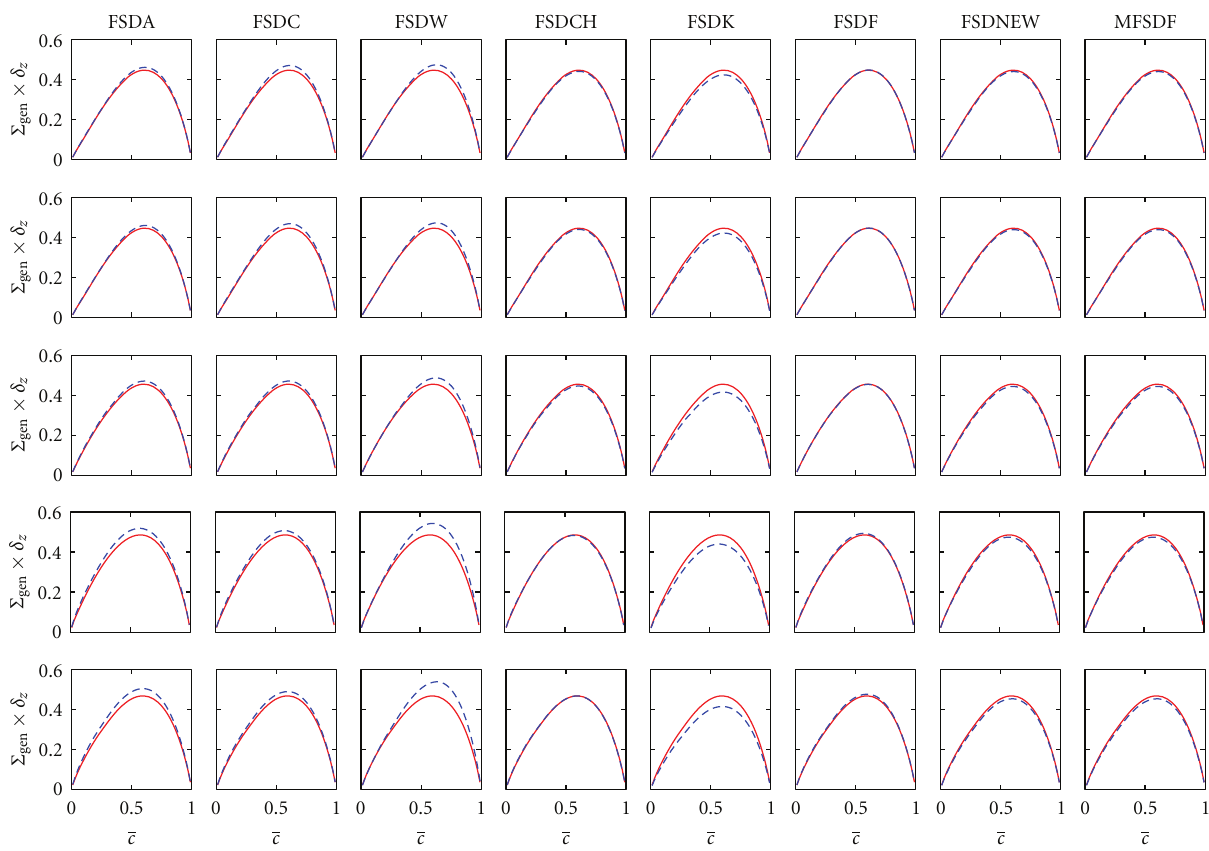
Figure 4: Variation of the mean values of Σ gen × δ z conditional on c across the flame brush for Δ = 8 Δ m = 0 . 8 δ th according to the DNS ( ) and model ( ) for cases A (1st row), B (2nd row), C (3rd row), D (4th row), and E (5th